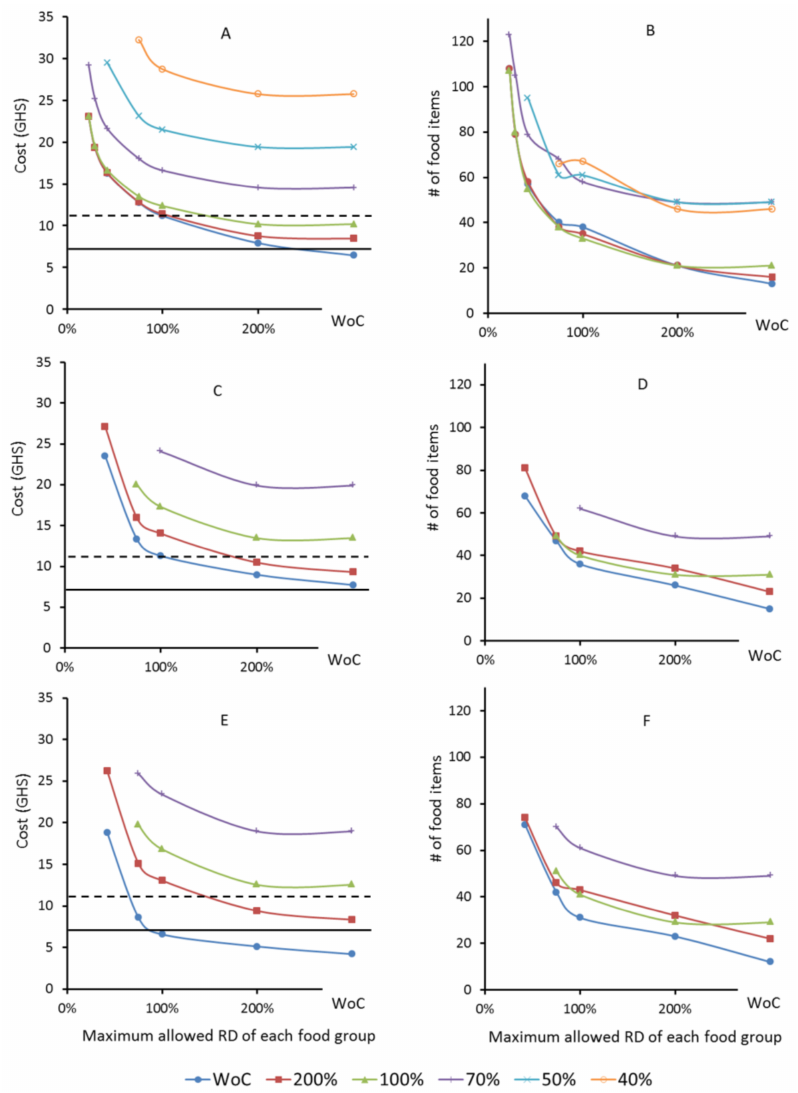
Figure 1. Cost ( A , C , E ) and diversity ( B , D , F ) of food baskets (FBs) for a Ghanaian family of four. Each point within the charts represents a nutritionally adequate FB. The FBs were optimized based on the foods available in the urban (UFB: urban food basket, Charts A , B ) or in the rural environment (RFB: rural food basket, Charts C , D ). Charts E+F build also on foods available in rural areas but include wild foods (RWFB: rural wild food basket). In the charts, each line represents a set of FBs that underlies the same constraint on the maximum contribution of a single food per food group (without constraint (WoC), 200%, 100%, 70%, 50% and 40%). Values on the X-axes indicate maximum allowed relative deviation ( RD ) from food group weights reported by most recent Ghanaian Food Balance Sheets [35]. The horizontal lines indicate threshold limits for poverty (USD 3.1, GHS 11.9, dashed) and extreme poverty (USD 1.9, GHS 7.3, solid). GHS, Ghanaian